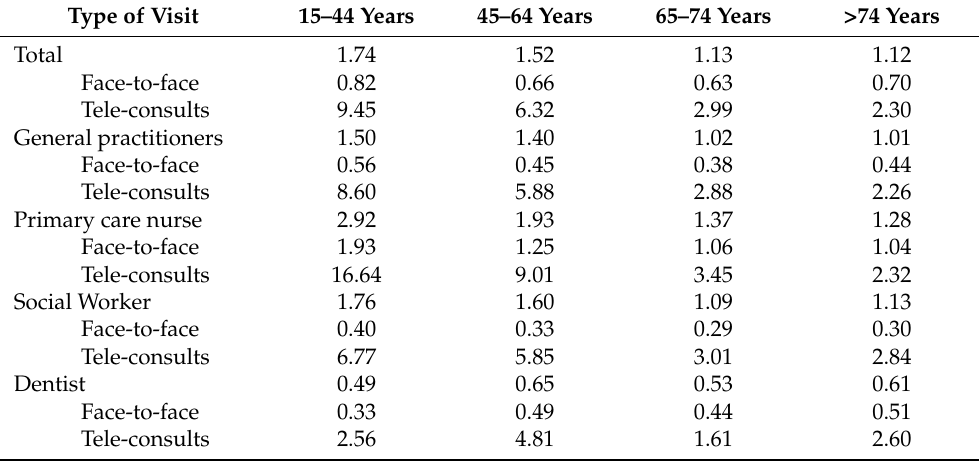
Table 2. Visit ratios between 2020 and 2021 and mean visits from 2017 to 2019 according to age groups (15–44, 45–64, 65–74, and >74 years). Values are represented as visit ratios for the number of visits